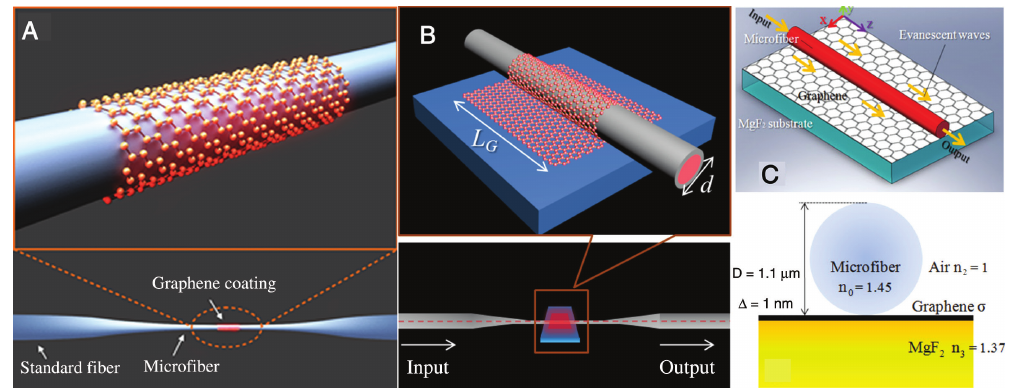
Figure 3: 2D material-decorated microfiber photonic device fabrication using the covering/wrapping/attaching method. (A) Graphene-wrapped microfiber. Reproduced with permission [128]. Copyright 2014 American Chemical Society. (B) Graphene-covered microfiber. Reproduced with permission [129]. Copyright 2014, The Optical Society. (C) Microfiber-attached graphene. Reproduced with permission [130]. Copyright 2013, The Optical Society.